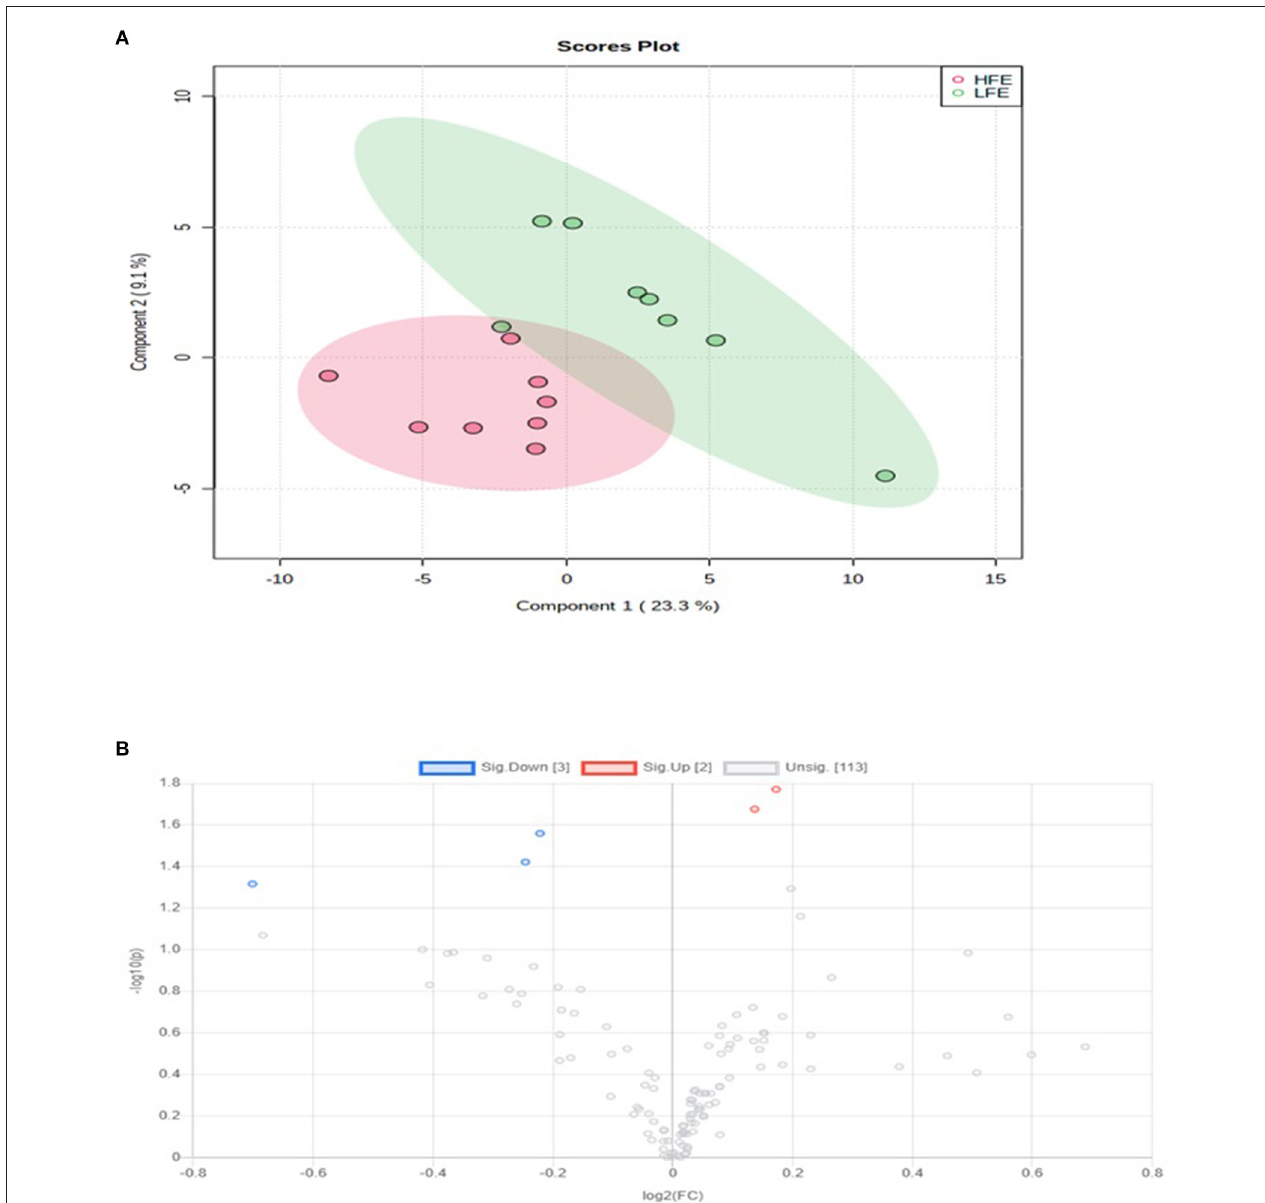
FIGURE 6 | (A) PLS-DA scores plot of carbonyl-metabolome of LFE and HFE steers; (B) Volcano plot showing the differentially abundant carbonyl-containing metabolites. Metabolites with false discovery ratio ≤ 0.05 (red or blue) are differentially increased or reduced in HFE, relative to LFE. HFE, beef steers with negative residual feed intake; LFE, beef steers with positive residual feed